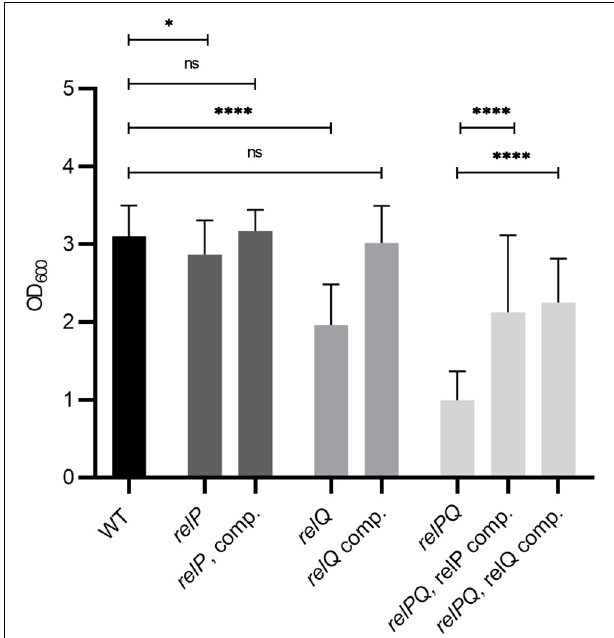
FIGURE 2 | RelP and RelQ affect biofilm formation synergistically. Biofilm formation under vancomycin-stress (0.78 µ g/ml vancomycin) in CDM. Strains: HG001 wild type, relP and relQ single mutants, relPQ double mutant and complemented strains. Three separate experiments were performed with biological triplicates each. Error bars represent the standard deviation, statistical significance based on ordinary one-way ANOVA (ns: not significant, *: P < 0.1, ****: P < 0.0001).